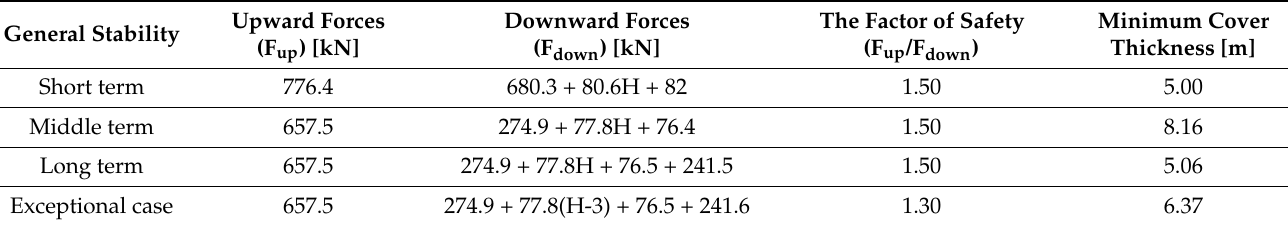
Table 1. Calculation of minimum cover thickness above the